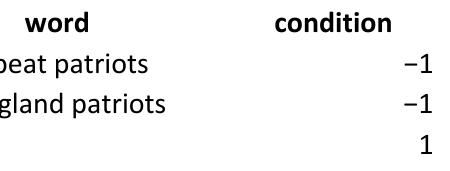
Figure 2. Demonstrating use of the Keyword Filtering option, also saved in CSV format.